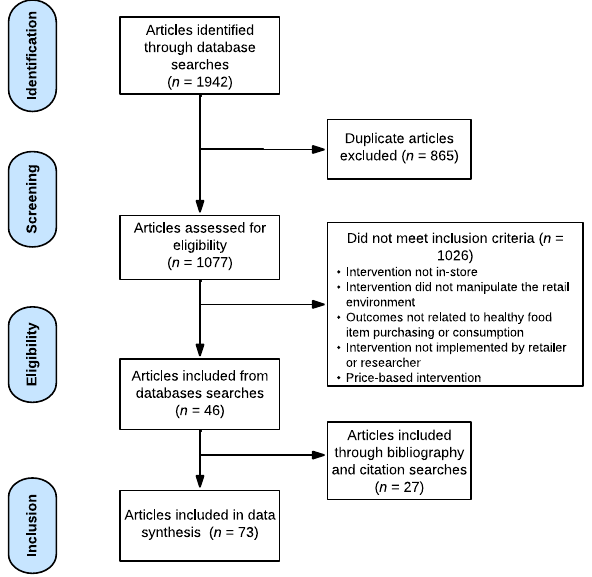
Figure 1. Article Inclusion